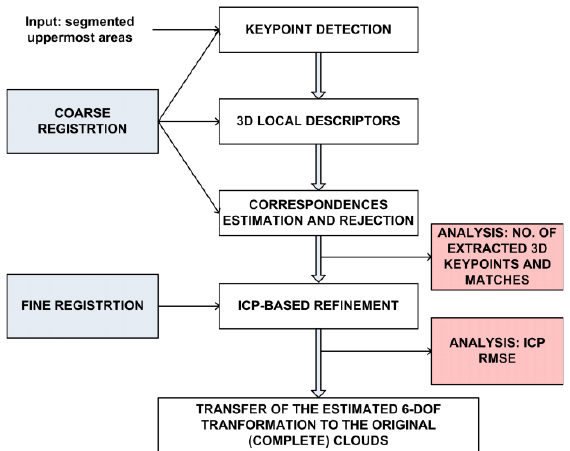
Figure 7. The adopted feature-based pipeline for pairwise point cloud registration.